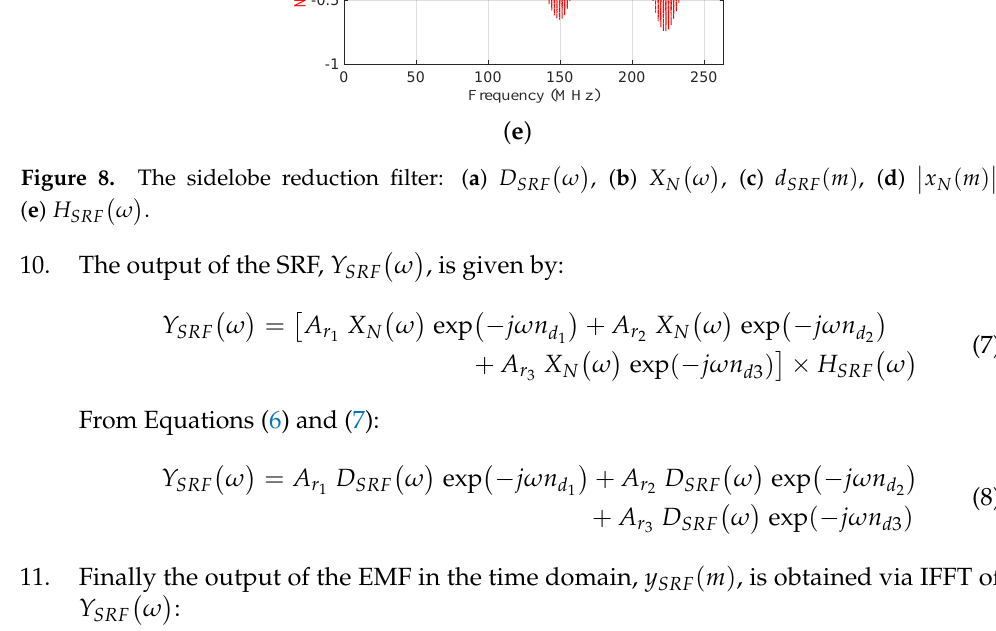
(cid:12) (cid:12) x N ( m )